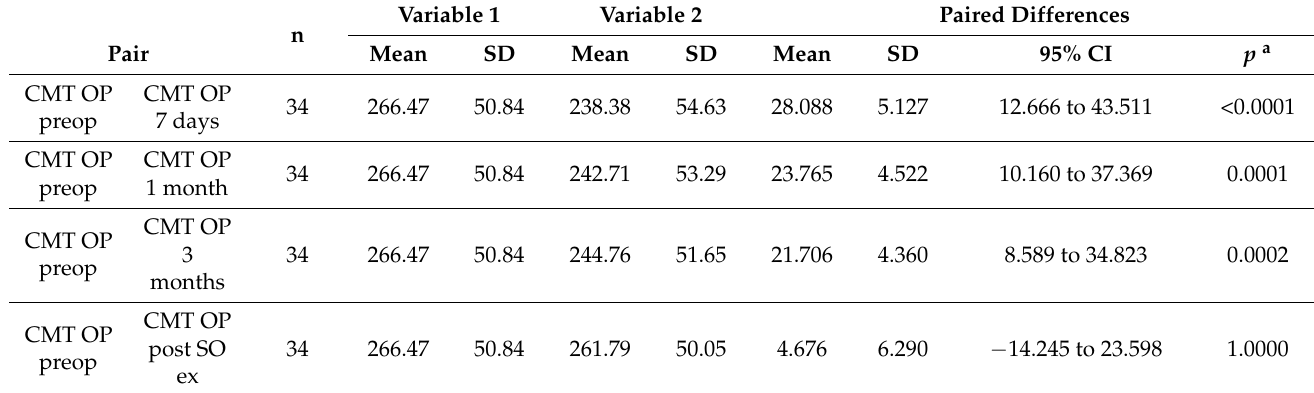
Table 2. Central macular thickness—CMT ( µ m) in PPV SO operated eyes.